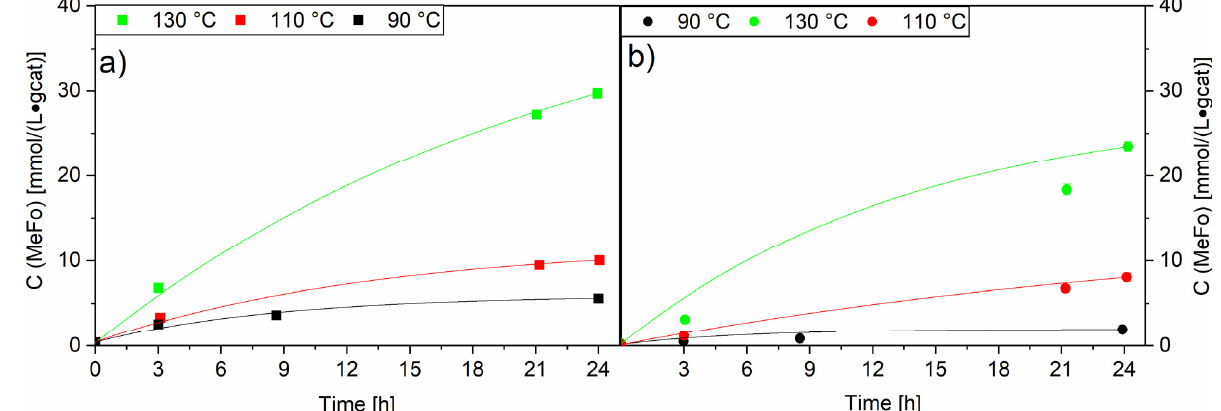
Figure 11. Comparison of temperature variation for RuNi-NO-ir. (Graph ( a )) and RuNi-Cl-ir. (Graph ( b )) catalysts. Solid lines (filled squares and circles) show concentration of methylformate. Black lines show the concentrations generated at 90 °C, red lines show the concentrations generated at 110 °C and green lines show the concentrations generated at 130 °C. Testing conditions: 80 bar, CO:H 2 1:3, 50 mL methanol, quantification: GC-FID (PolyArc).